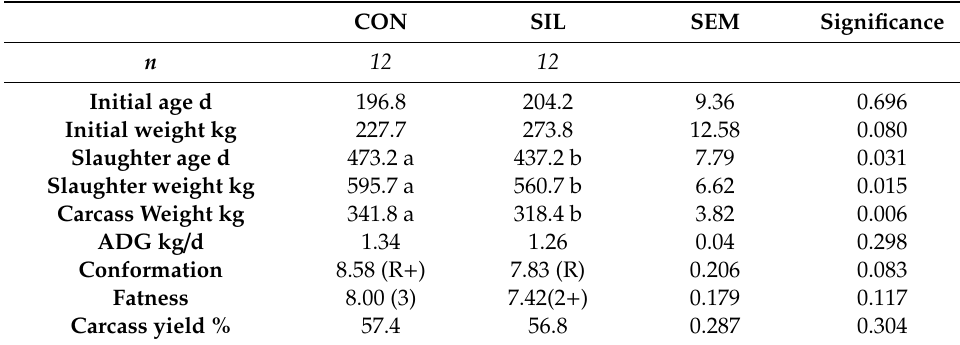
Table 2. Production traits and meat quality of Avileña-Negra Ib é rica yearlings feeding with concentrate (CON) or 70% maize silage + 30% concentrate